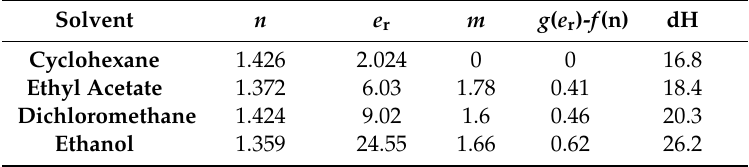
Table 1. Organic solvents used, n : Refractive index; e r : Relative permittivity; µ : Dipolar moment; g ( e r )- f (n): Orientation polarization; dH: Hildebrand parameter.